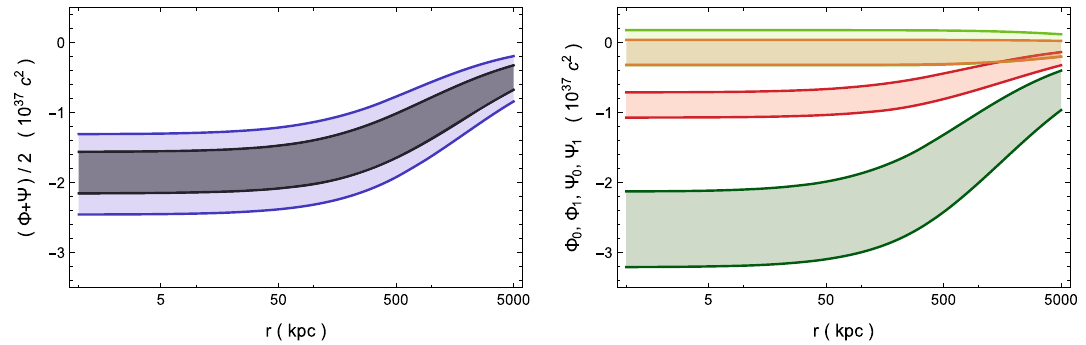
Fig. 1 Concentrations and masses of CLASH clusters: (top panels) comparison between our results and those from [65] in the GR scenario; (bottom panels) comparison between the GR and the nonlocal scenario from our analysis